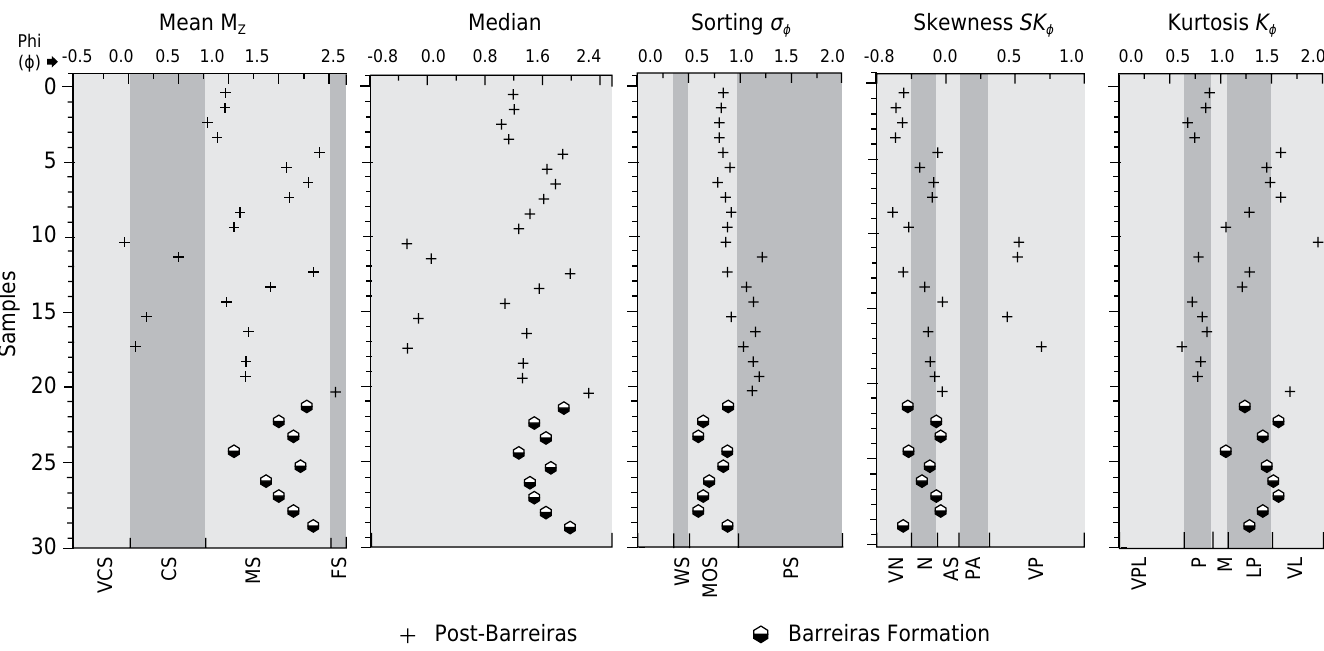
Post-Barreiras Barreiras Figure 3. Sedimentological parameters of Post-Barreiras and Barreiras Formation. Mean (VCS: very coarse sand; CS: coarse sand; MS: medium sand; and FS: fine sand); Sorting σ 1 (WS: well sorted; MOS: moderately sorted; and PS: poorly sorted); Skewness (VN: very negative; N: negative; AS: approximately symmetric; PA: positive asymmetry; VP: very positive); Kurtosis (VPL: very platykurtic; P: platykurtic; M: mesokurtic; LP: leptokurtic; VL: very leptokurtic).